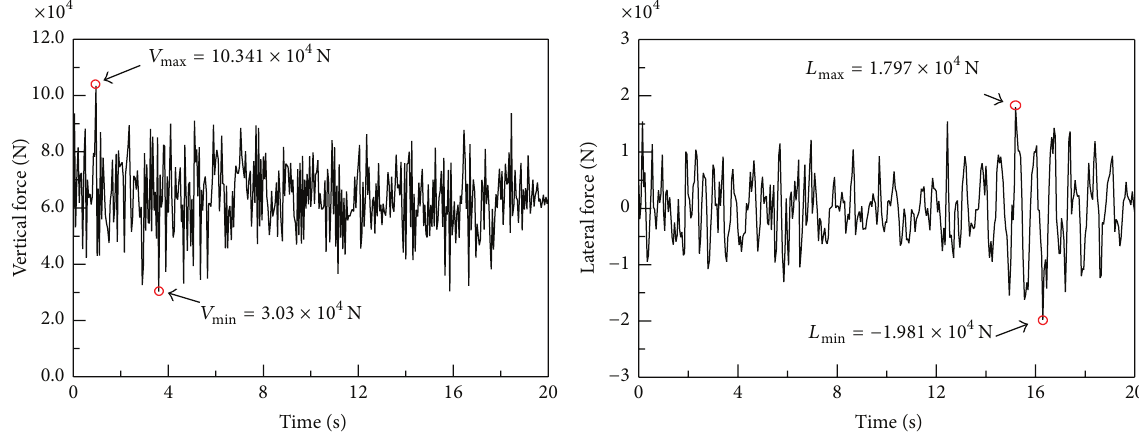
Figure 15: Time histories of vertical and lateral wheel-rail force of the first wheel set subjected to earthquake.